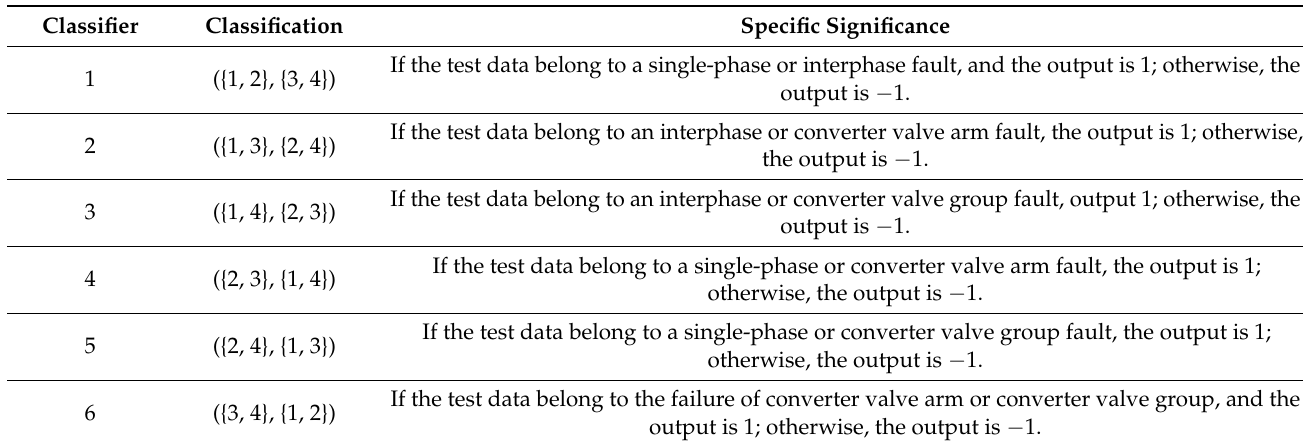
Table 3. HVDC system fault classification modes and